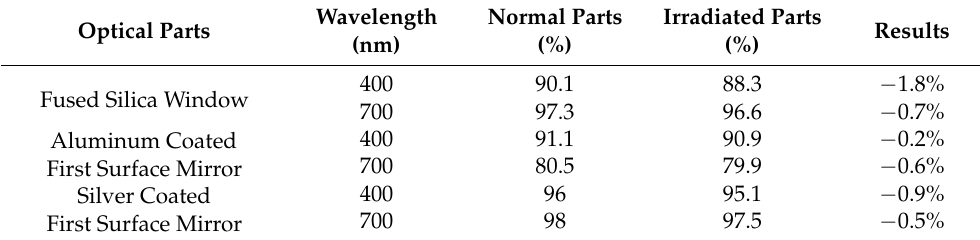
Table 1. Light Transmittance for Window and Light Reflectance for Mirror.